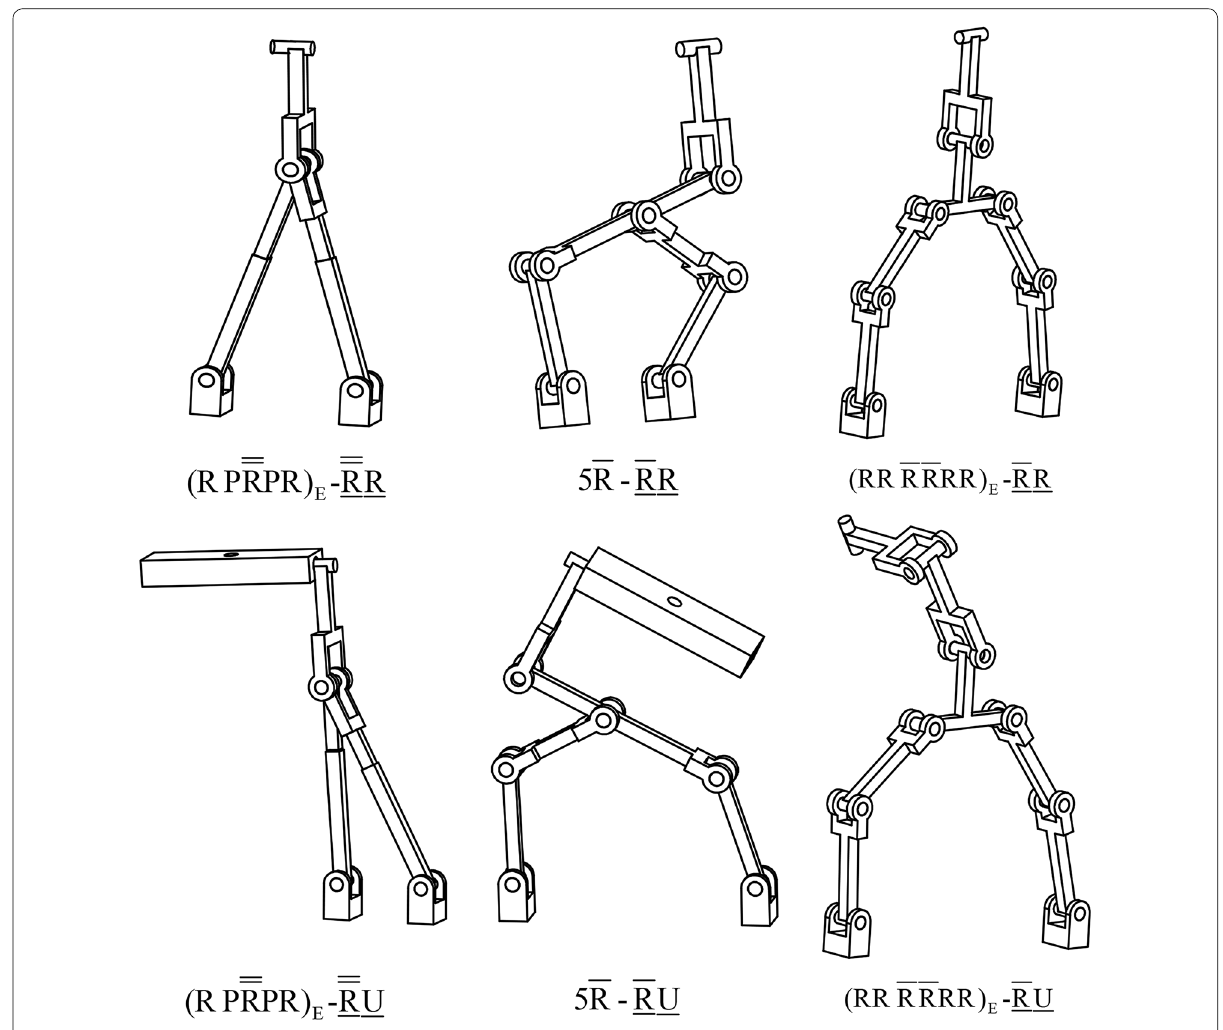
Figure 6 Partial branch